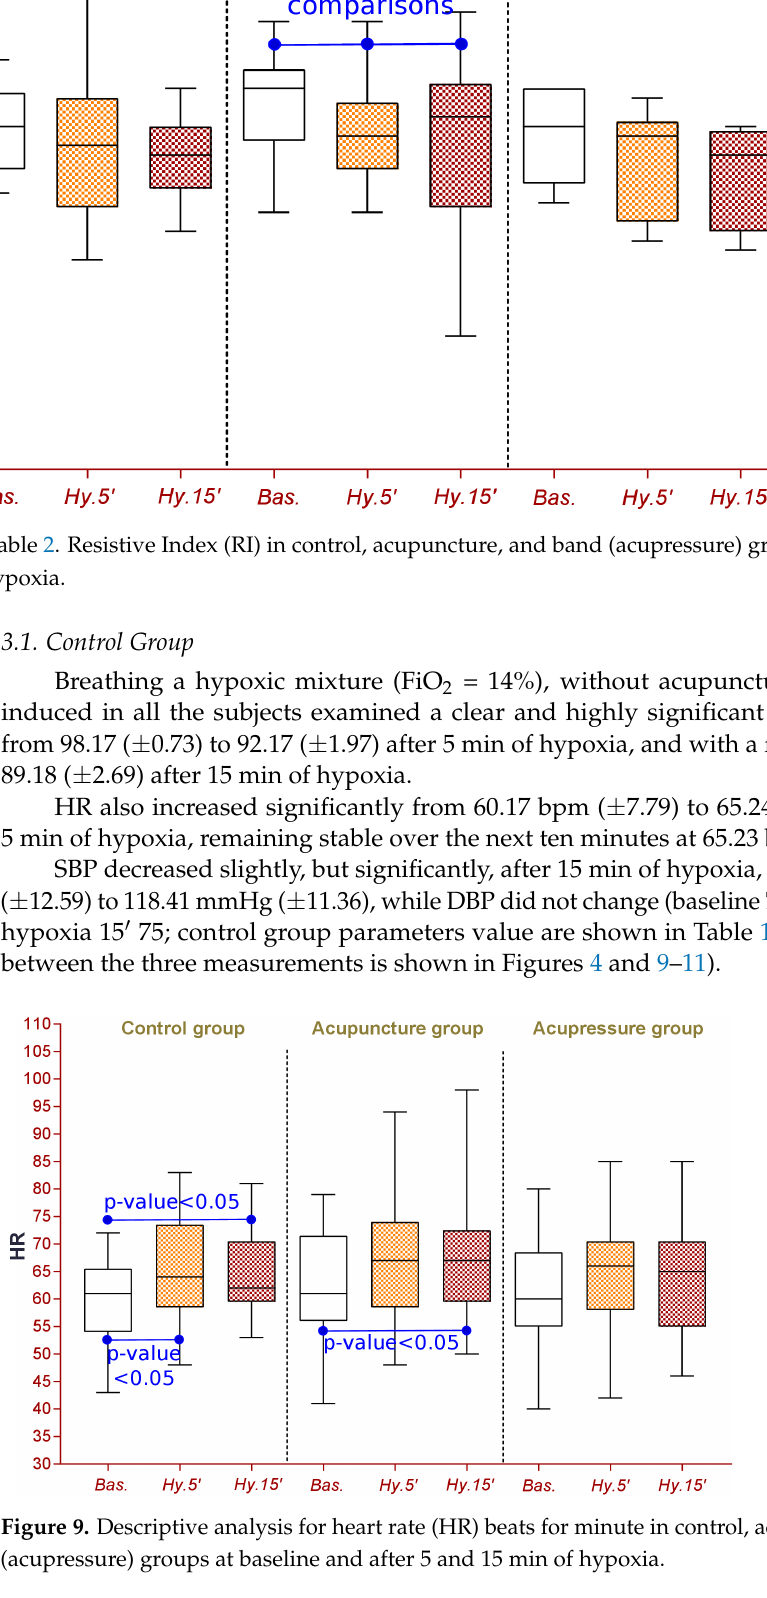
Figure 10. Descriptive analysis for millimeters of mercury systolic blood pressure (SBP) in control, acupuncture, and band (acupressure) groups at baseline and after 5 and 15 min of hypoxia.